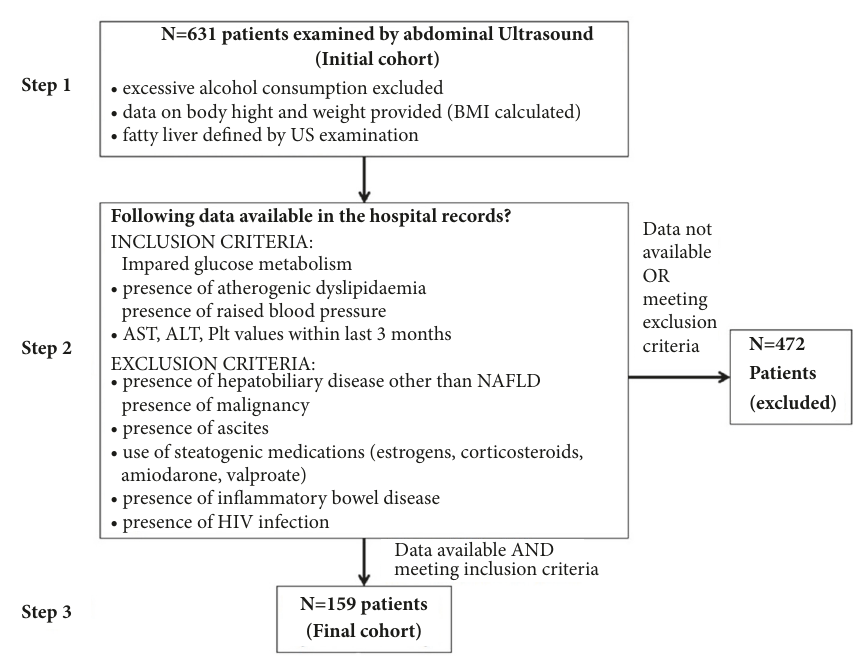
Figure 1: Study protocol. N: number of patients; BMI: body mass index; US: ultrasound; AST: aspartate transaminase; ALT: alanine aminotransferase; Plt: platelet count; NAFLD: nonalcoholic fatty liver disease; HIV: human immunodeficiency virus.